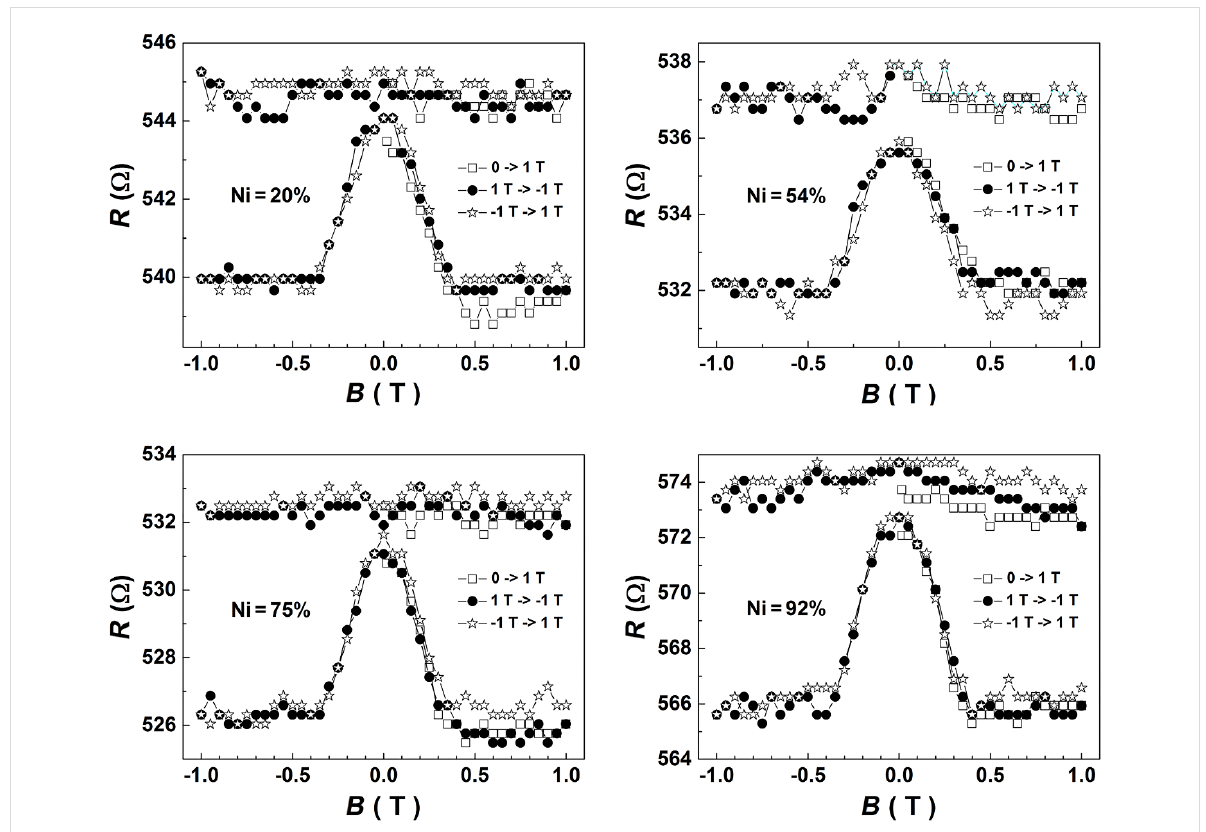
Figure 2: Magnetoresistance measurements obtained on the four single Ni–Cu alloy nanowires analyzed (corresponding to different concentrations of Ni), in both parallel (flat upper curves) and perpendicular (peaked lower curves) geometry. With no field applied, the magnetization lies along the wire due to the strong shape